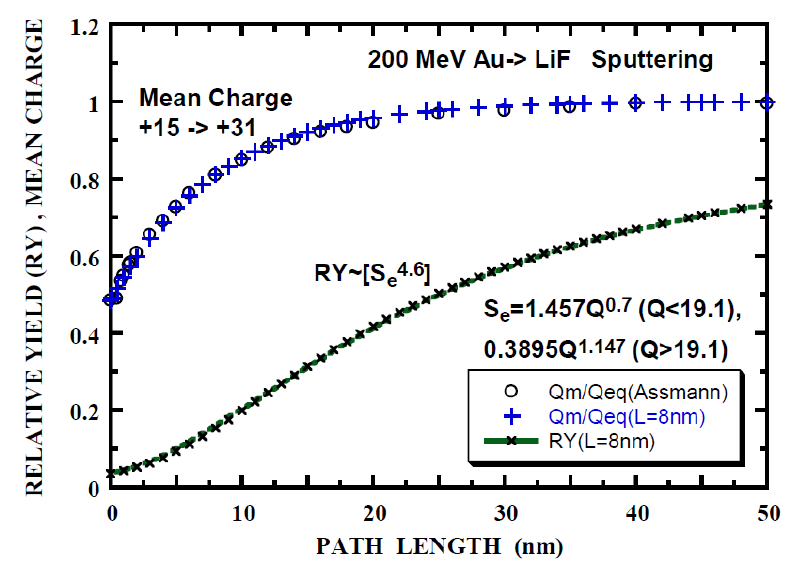
Figure 8. Relative yield (RY) of the electronic sputtering of LiF by 200 MeV Au +15 (x) calculated with n = 4.6, S e = 1.457Q 0.7 (Q < 19.1) and S e = 0.3895Q 1.147 (Q > 19.1) as a function of path length. Open circles (o) is the mean-charge evolution from [36] normalized to the equilibrium-charge Q eq = 31 and saturation approximation (Equation (2a)) with L = 8 nm and Q o = 15 (+). Integrand for RY is indicated by [ ].